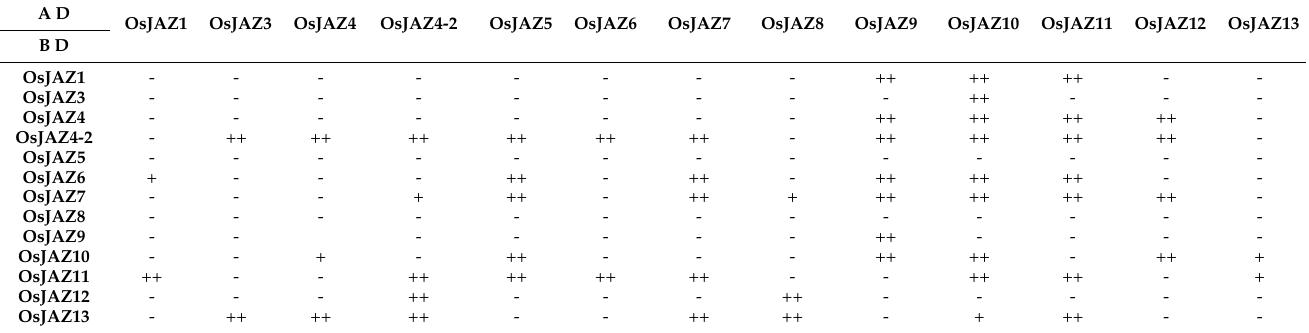
Table 1. Summary of OsJAZ–OsJAZ interactions in yeast. Each of the 13 full-length rice JAZs was tested in both AD (top row) and BD (left column) orientations. Based on the intensity of colony growth, the strength of each interaction was rated as strong (++), weak (+), or undetectable (-), as shown in Figure